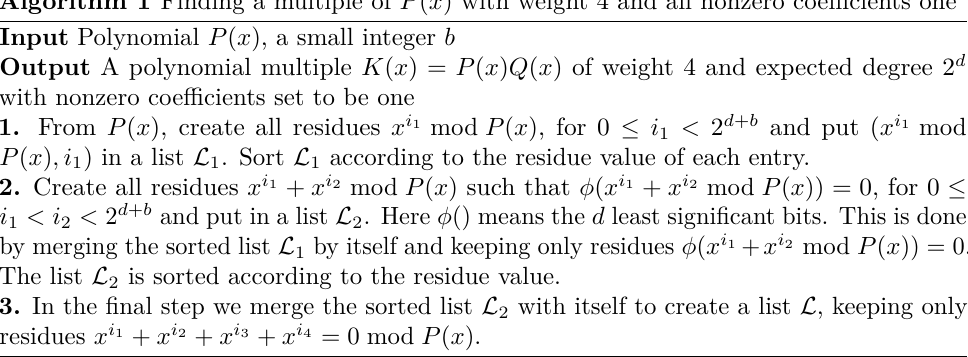
Algorithm 1 Finding a multiple of P ( x ) with weight 4 and all nonzero coefficients